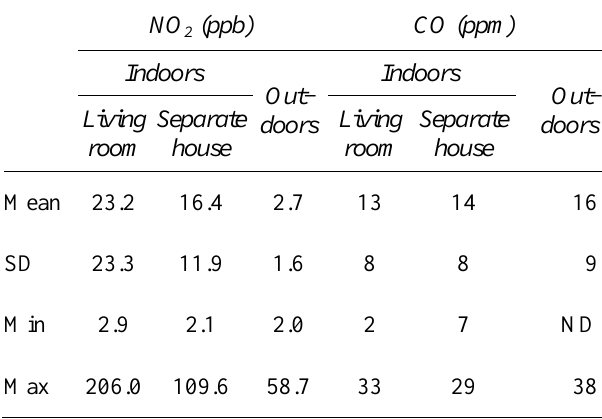
Table 6: NO and CO concentrations in different kitchen 2